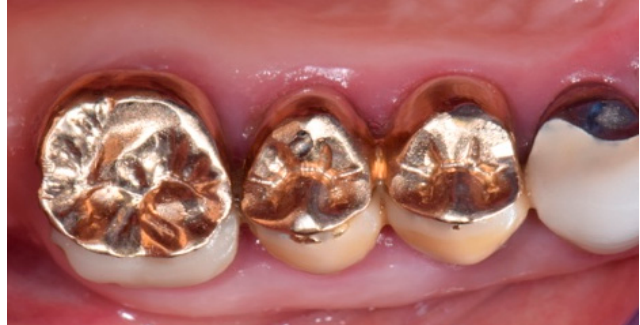
Figure 1. Initial intra-oral clinical view of the suspected fracture of upper right premolar (1.5 teeth) (quadrant I) of a patient, showing the premolars and molar (1.4, 1.5 and 1.6 teeth) prosthetically restored with gold-ceramic crowns.